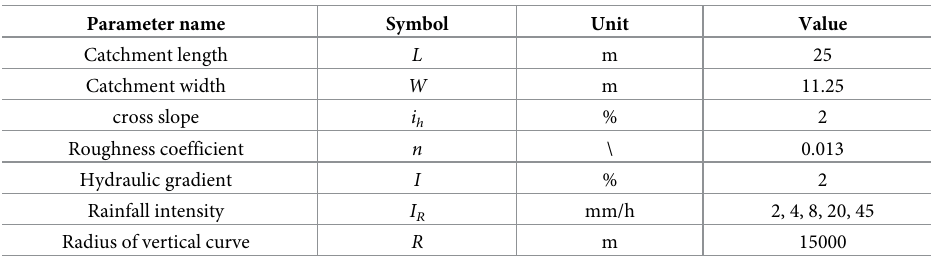
Table 4. Parameter